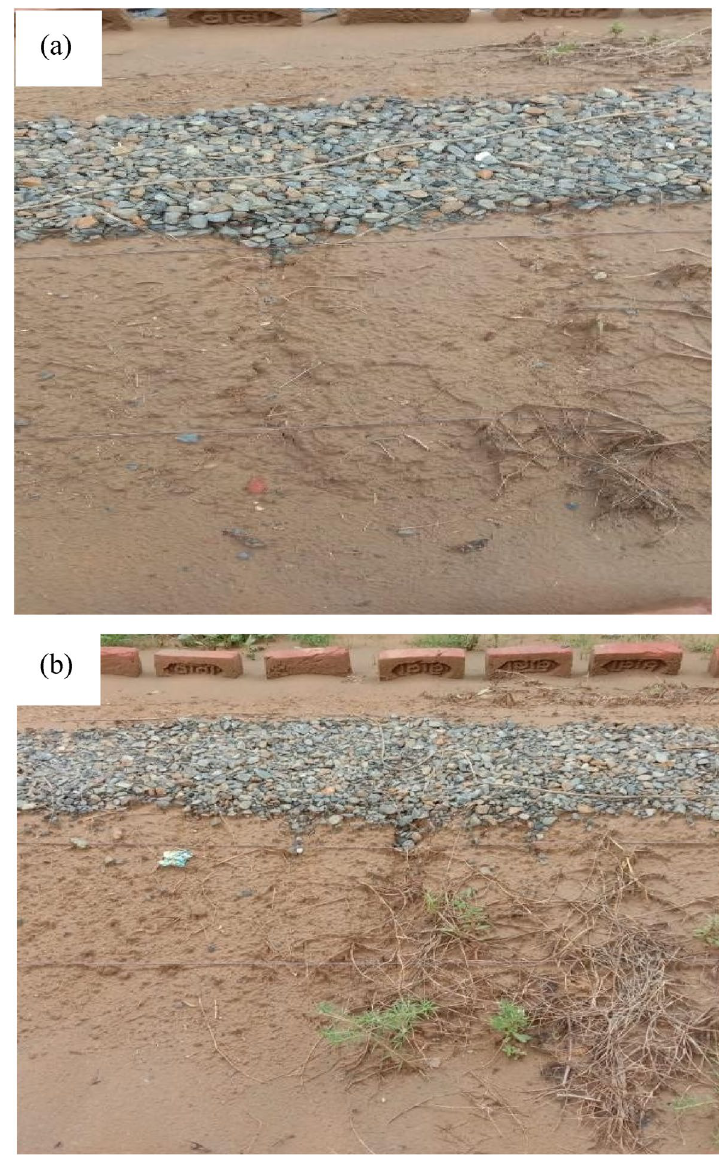
side of longitudinal